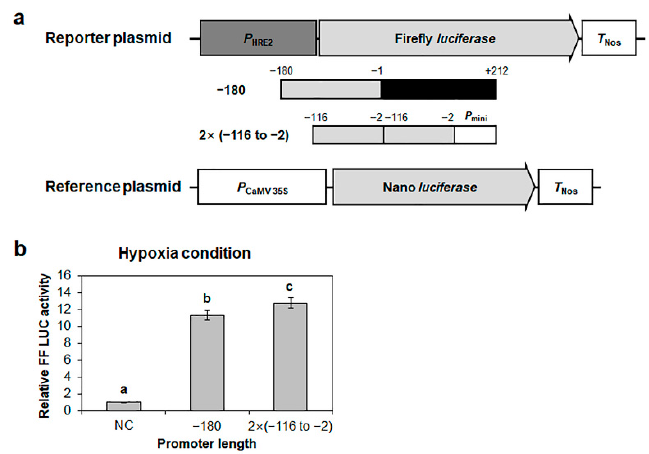
Figure 4. Confirmation of hypoxia-responsive promoter region in HRE2 promoter. ( a ) Schematic maps of reporter and reference plasmids for HRE2 promoter activity analysis. ( b ) Relative firefly luciferase activity in Arabidopsis protoplasts. Transformation efficiency was normalized using Nano luciferase activity. Normalized firefly luciferase activity of the negative control was set as 1. Empty reporter plasmid was used for the negative control. Data are shown as means ± S.D. ( n = 3). Different letters display significant differences ( p <